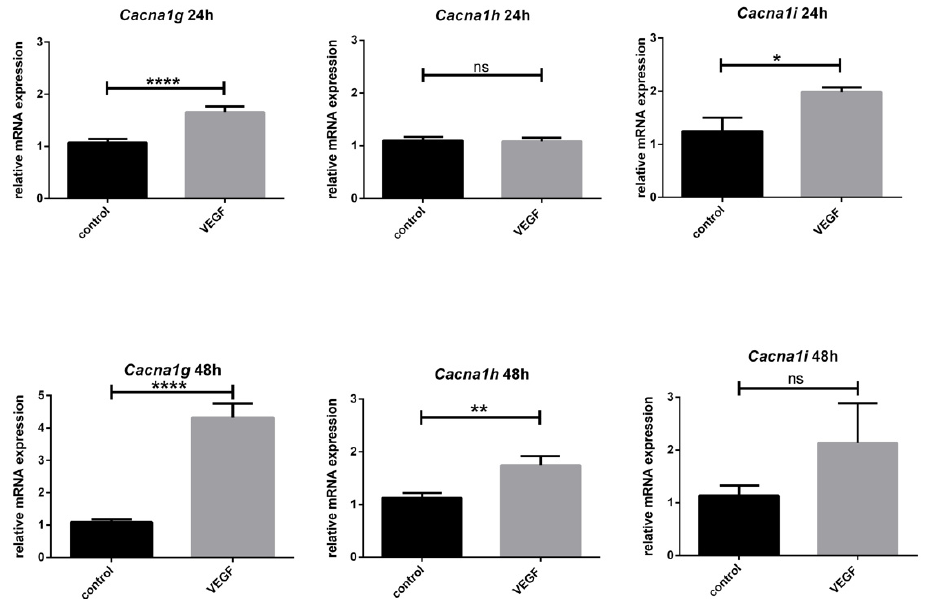
Figure 7. Effect of VEGF on Cacna1g , Cacna1h , and Cacna1i expression: The graphs show the relative mRNA expression of Cacna1g , Cacna1h , and Cacna1i with or without VEGF treatment for 24 h and 48 h. The values were normalised against the control group and the housekeeping gene was Gapdh . n = 8, significant differences are indicated by * p < 0.05, ** p < 0.01, **** p < 0.0001; ns = not significant.